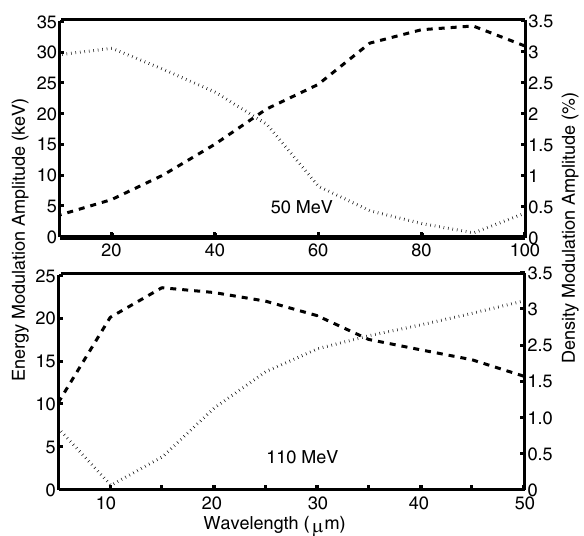
FIG. 6. Numerical simulation results. The spectral shapes of final density (dotted curves) and energy (dashed curves) modu- lation for 50 and 110 MeV assuming (cid:9) 3% initial density modulation at all